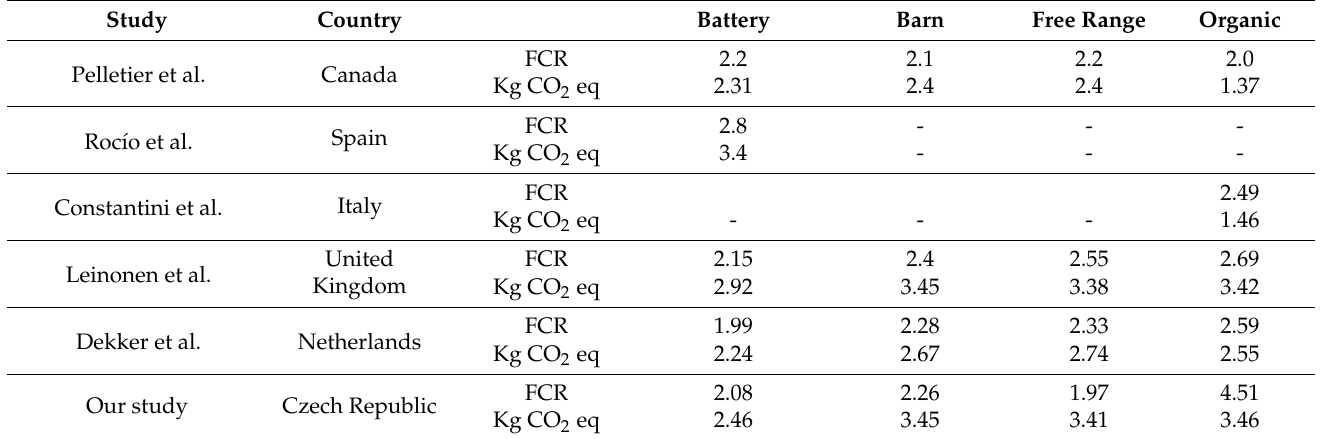
Table 6. Climate change potential in kg CO 2 eq. and feed conversion ratio for one kilogram of eggs; a comparison with other LCA